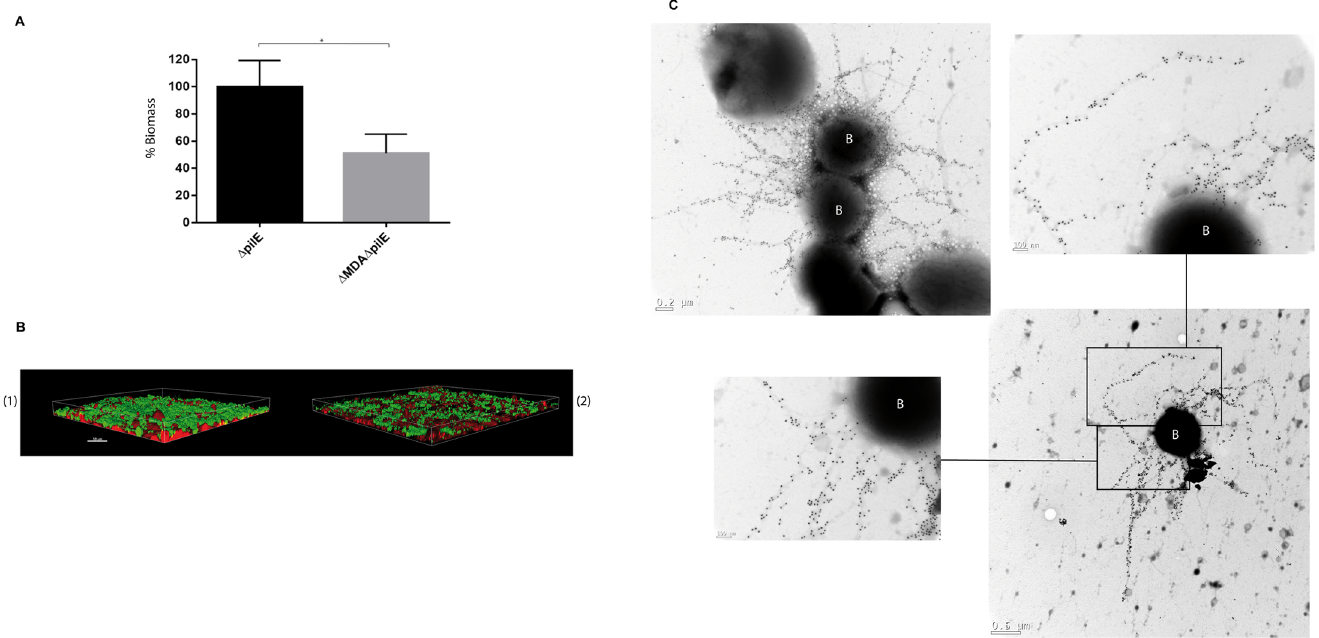
Fig 7. Meningococcal biofilm formation of non piliated strains onto epithelial cells. (A) Quantificationof the biomass covering cells infected with pilE mutants (Z5463 gfp Δ pilE and Z5463 gfp Δ pilE Δ MDA).Mutants were grown onto FaDu epithelialcells for 18 hours under constant flow. At least three independent experiments were performed. The results are normalized as a percentage of the mean biomass of Z5463 gfp Δ pilE ,which was set to 100%. Error bars indicate the standard errors of the mean (SEM). * p < 0.05 (Student t test). (B) Three-dimensionalbiomassof colonizingbacteriareconstructed with the Imaris software. (1) non piliatedstrain. (2) a prophagedeletedisogenicmutant of the non piliatedstrain. Both strains were grown onto FaDu epithelial cells for 18 hours under constant flow shear stress. Representative images of experiments performed on at least three different occasions. Bacteria are stainedwith GFP (in green) and epithelial cells are stained with cytoplasmic Cell Tracker Orange CMTMR (in red). (C) Immunogold-labelling of Z5463 gfp Δ pilE strain. Materialwas harvestedfrom a flow chamberas above and labelledwith the anti-MDAORF4 polyclonal antibody.In this experiment, only 18 nm-diameter gold particles were used. Global view with some enlargements. The letter B in white correspondsto bacteria.